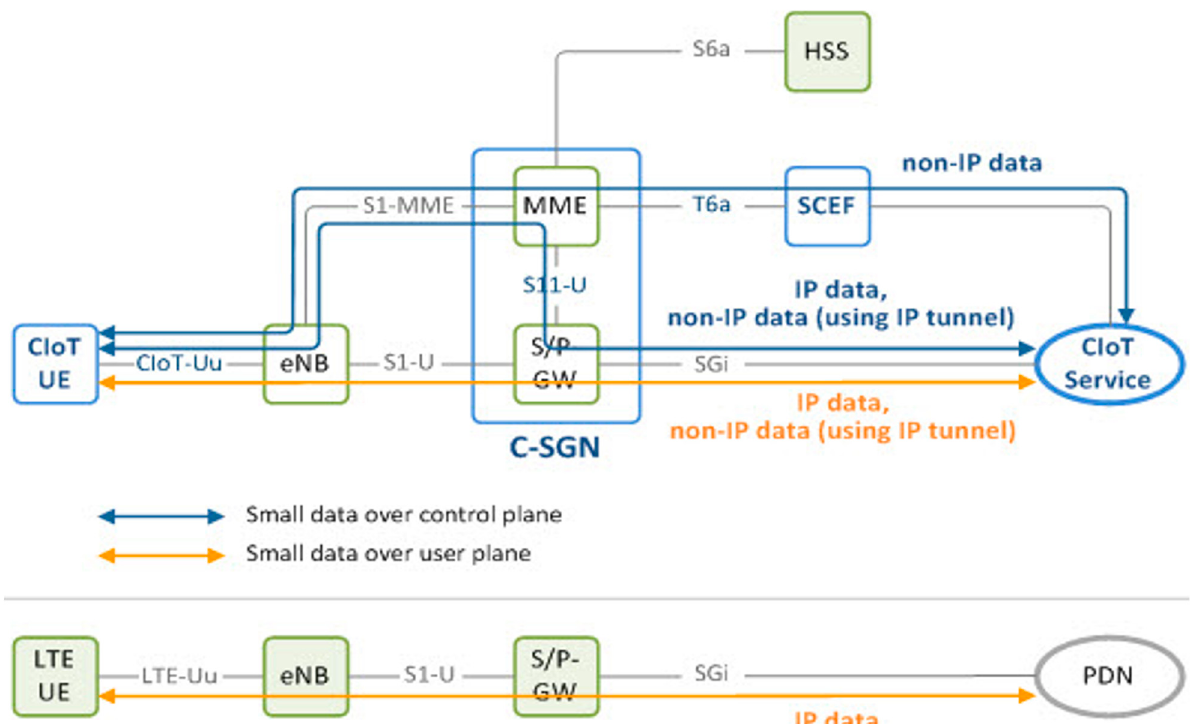
Figure 10. Optimized core IoT and NB-IoT data delivery network. The communication path through the EPC interfaces from the UE to the core IoT services.